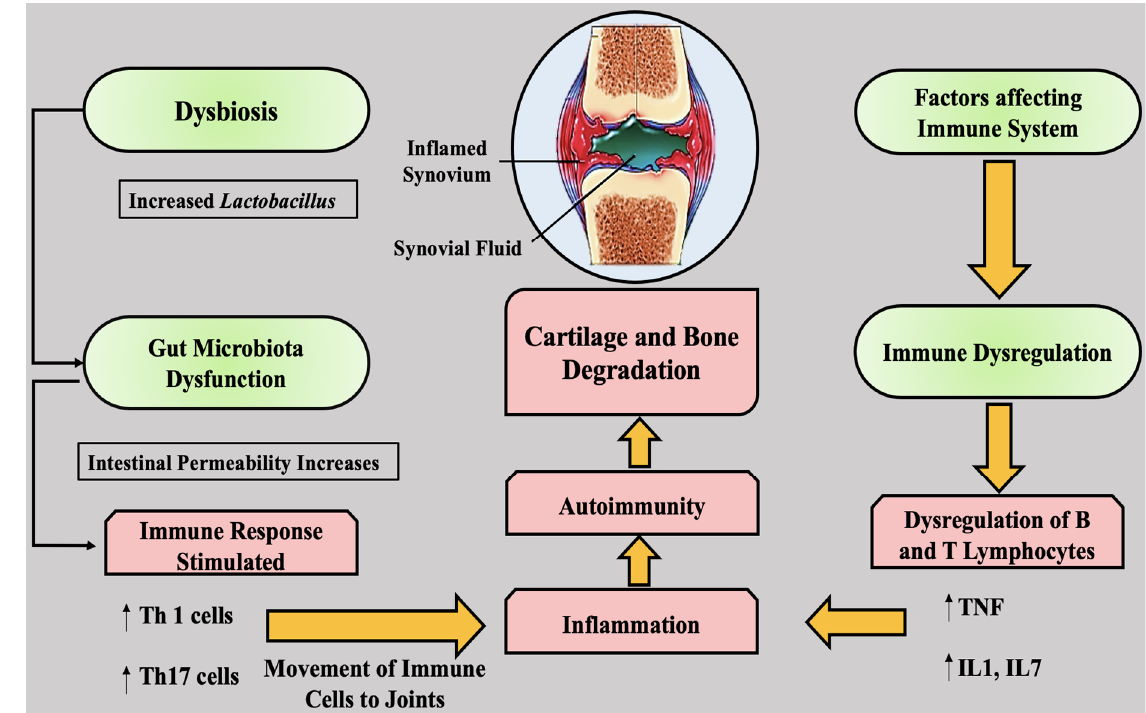
Figure 2. Factors affecting the immune system. Th, T helper; TNF, tumor necrosis factor; IL, interleukin; , increasing/ac- tivating/enhancing; , decreasing/inhibiting/reducing.